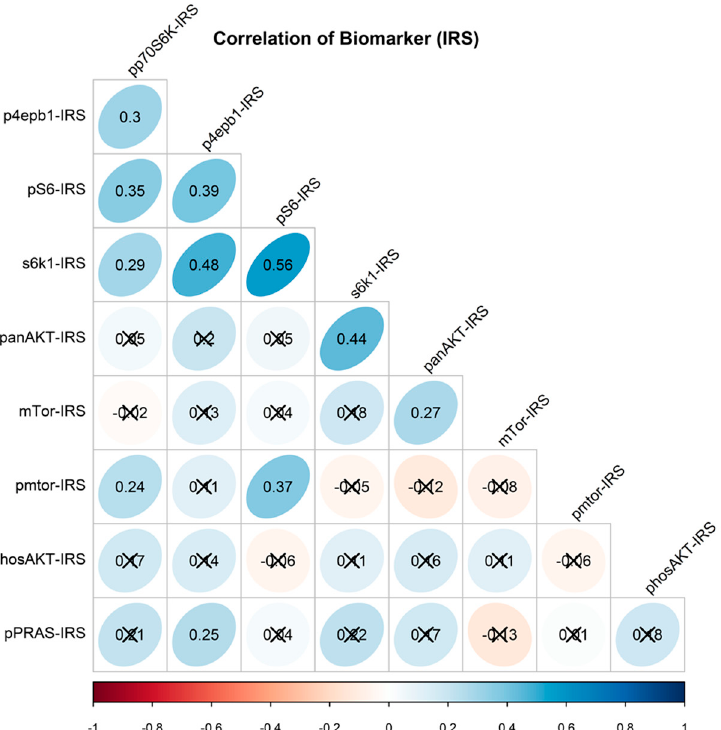
Figure 2. Correlogram depicting relationship between biomarkers. Correlation between two parameters was evaluated by the analysis of Spearman’s coefficient. Value of the respective association is delineated by the Spearman correlation coefficient (rs) in the oval. Blue ovals—positive rs, red ovals—negative rs. Color shade of the ovals represents the strength of the association (the darker—the stronger). Scored-out ovals—non-significant association.